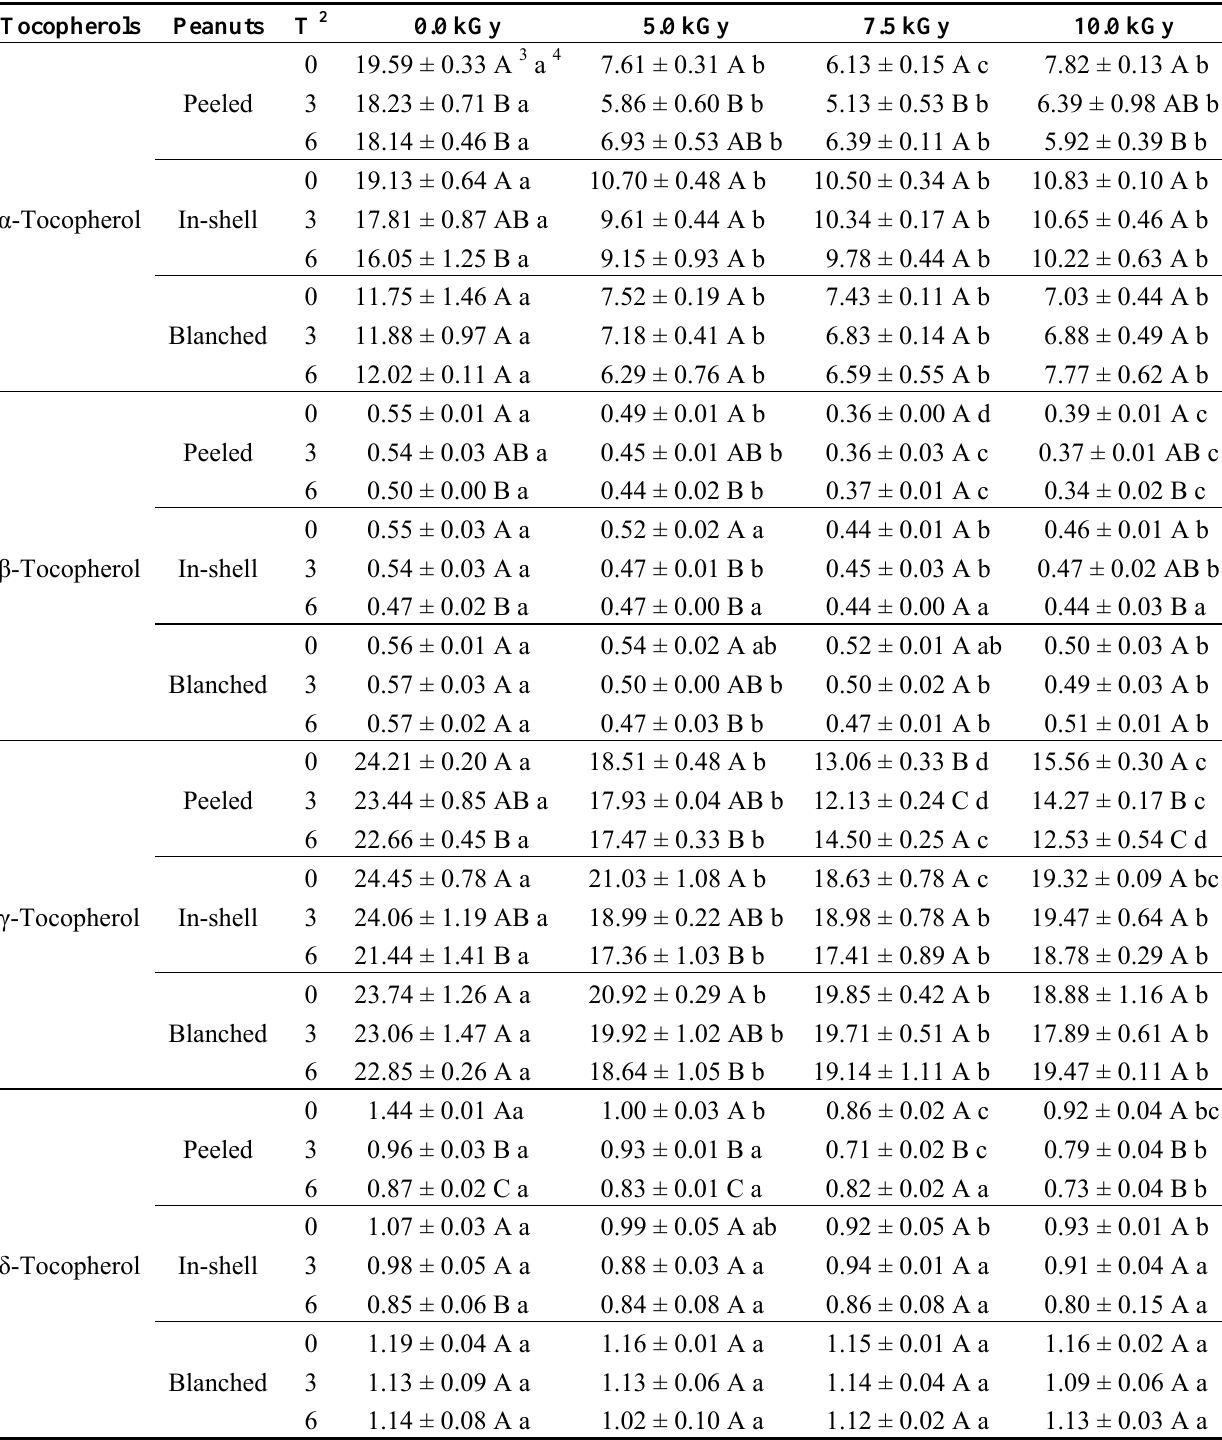
Table 3. Tocopherol contents of the peanut samples 1 (mg/100